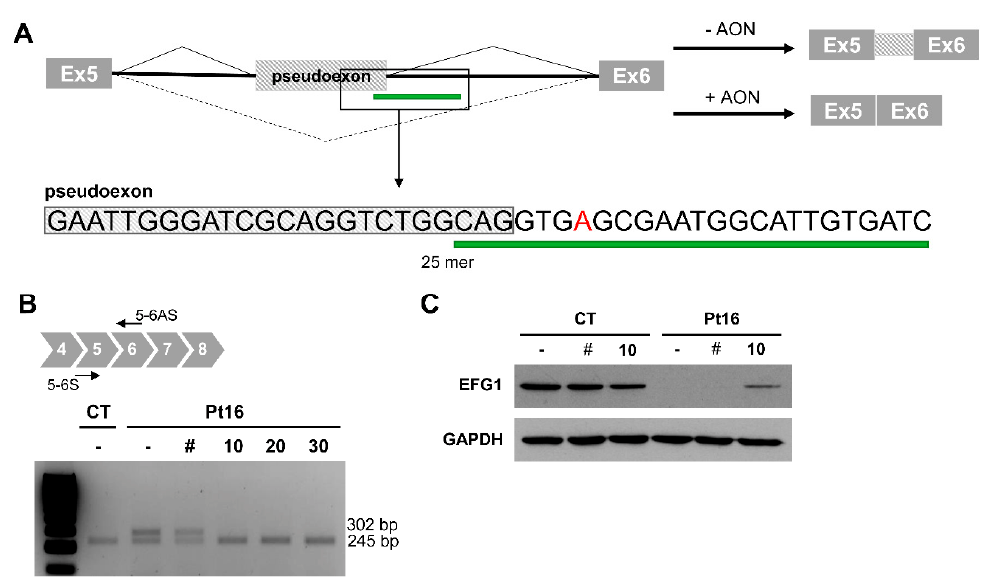
Figure 3. Antisense morpholino oligonucleotide-based pseudoexon skipping efficacy. ( A ) Diagram of the pseudoexon insertion caused by c.689+908G>A and the predicted effect of the antisense morpholino oligonucleotide (AON). Inset showing location and sequence of the 25mer AON. ( B ) Representative image of the RT-PCR product from mutant (Pt16) and wild type (CT) cells, non-transfected (-) and transfected with 10 µM of non-target control (#); or in the presence of different concentrations (0 to 30 µM) of GFM1 -specific AON. ( C ) EFG1 rescue upon treatment with 10 µM of non-target control (#) or GFM1 -specific AON.